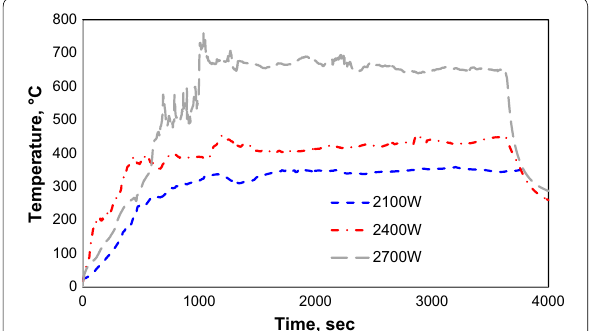
Fig. 2 Softwood pyrolysis temperature profiles